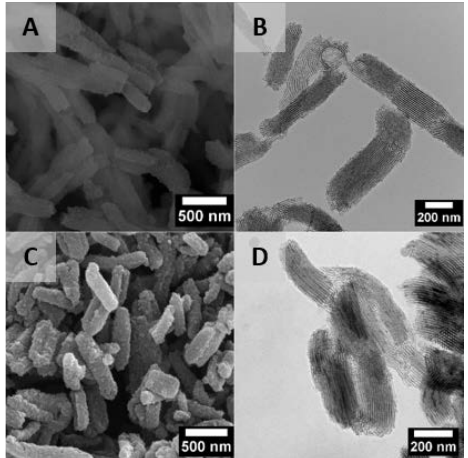
Figure 1. ( A ) SEM and ( B ) TEM images of pristine SBA-15 particles; ( C ) SEM and ( D ) TEM images of THY-loaded SBA particles. N = 100 particles.